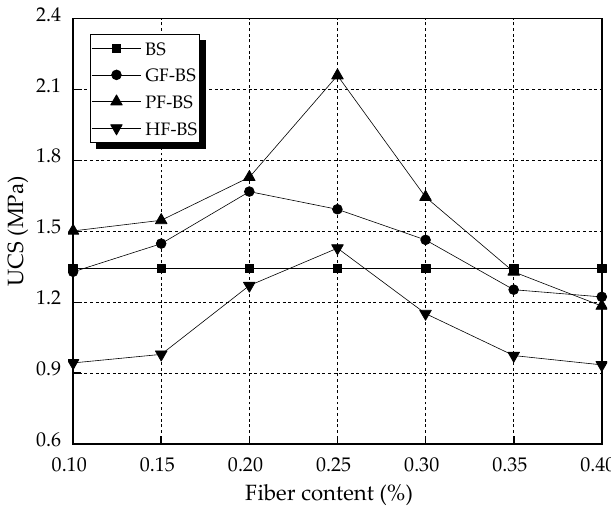
Figure 8. Unconfined compressive strength of biocemented sands.